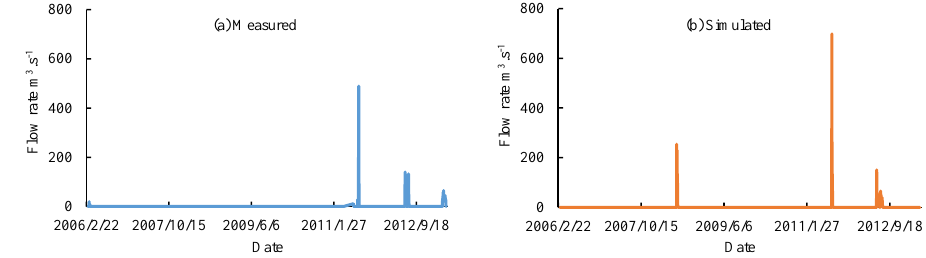
Figure 6. Comparison of simulated and measured diversion flow into Xinkai River at Taihekou Water Diversion